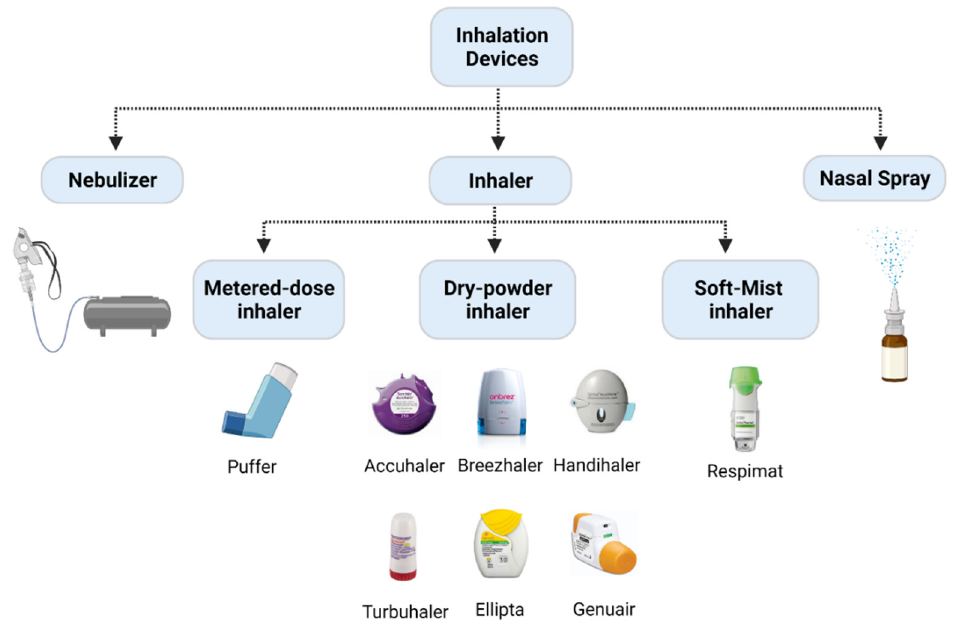
Figure 5. Examples of different inhalation devices. Inhalation devices are divided into nebulizer, inhaler (including pMDIs, DPIs, and SMIs), and nasal spray. pMDIs, pressurized metered dose